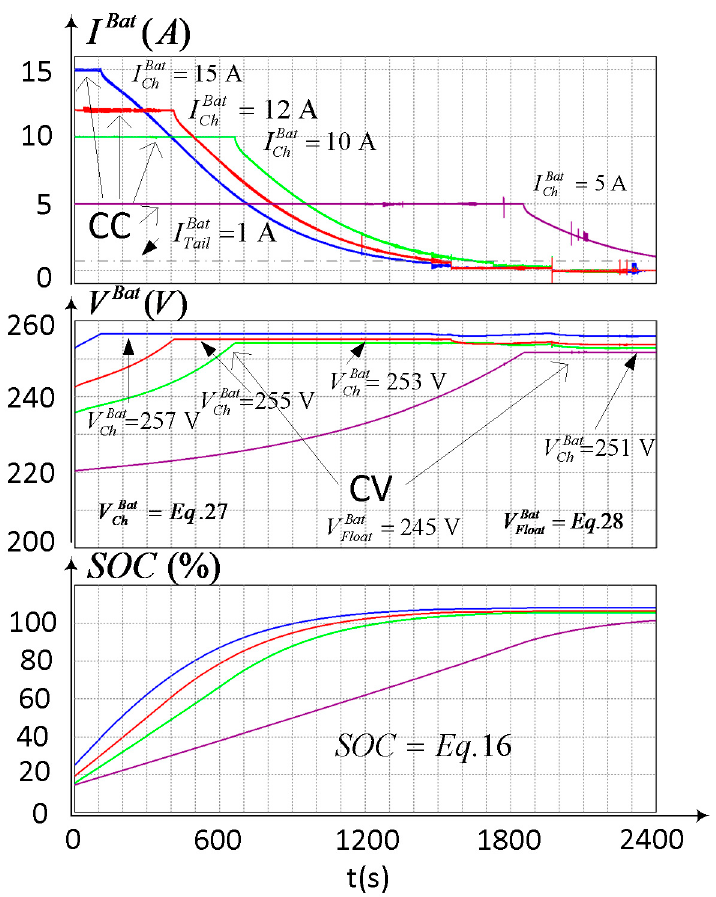
Figure 12. Simulation #1. Simulation waveforms of the charging procedure: I Bat , V Bat the SOC.